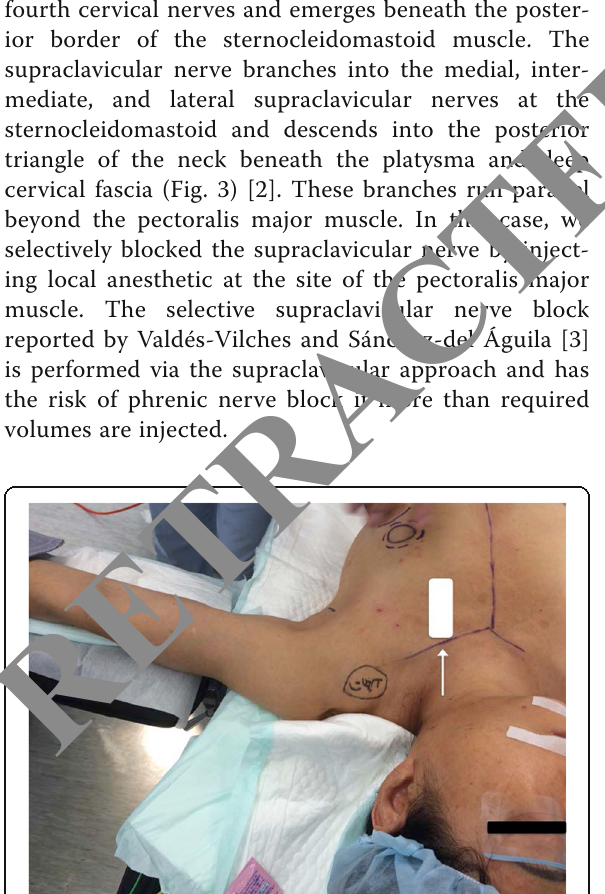
Fig. 3 An illustration of the supraclavicular nerve. SM sternocleidomastoid muscle, PM pectoralis major muscle, I intermediate, M medial, L